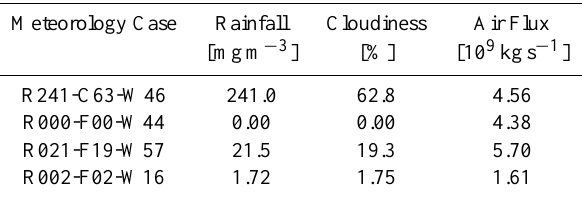
Table 2. Average pressure at the top of each vertical layer of the urban modeling